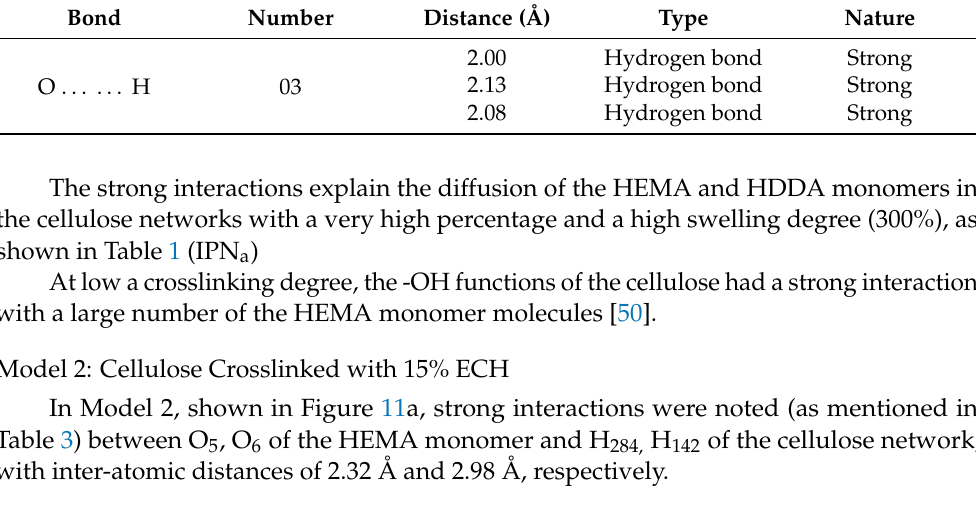
Table 3. Interactions in the system of cellulose hydrogel/HEMA monomer (ECH = 15%).